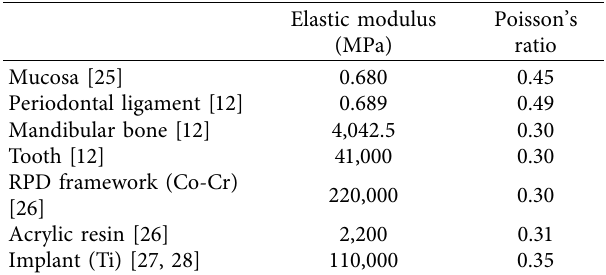
Figure 5: Full isotropic view of the FE model with loading and boundary condition. Table 1: Material